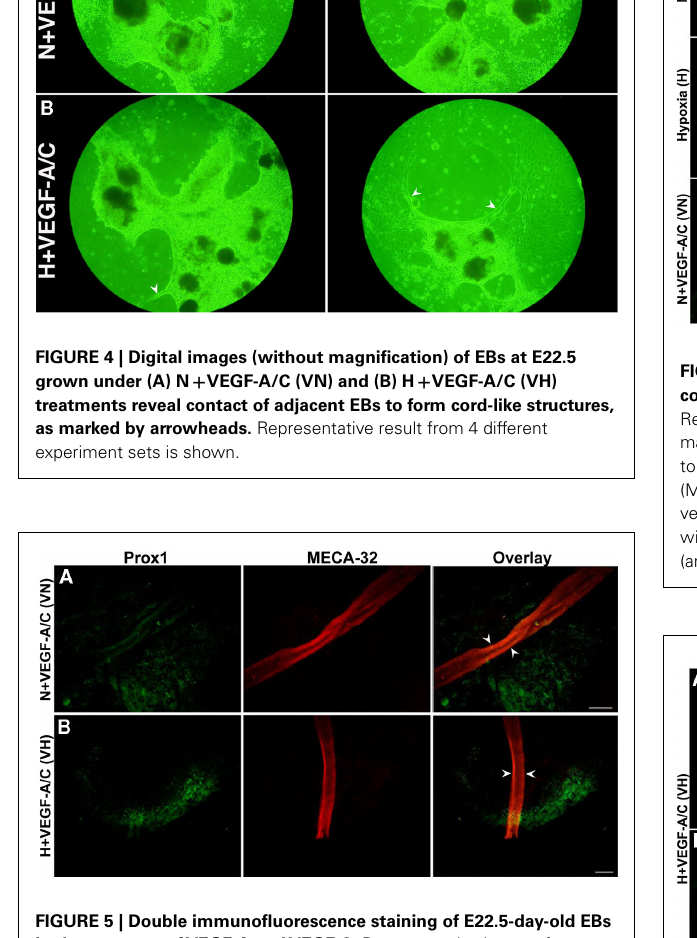
FIGURE 5 | Double immunofluorescence staining of E22.5-day-old EBs in the presence ofVEGF-A andVEGF-C. Representative images from three different experiments sets for each marker genes are shown. Arrowheads indicate MECA-32 positive blood vessel-like structures in E22.5-day-old EBs grown under bothVN (A) andVH (B) treatments. Prox1 positive LECs are in close proximity to the blood vessel-like structures. Images were taken at 40 × magnification (scale bar 30 μ m).